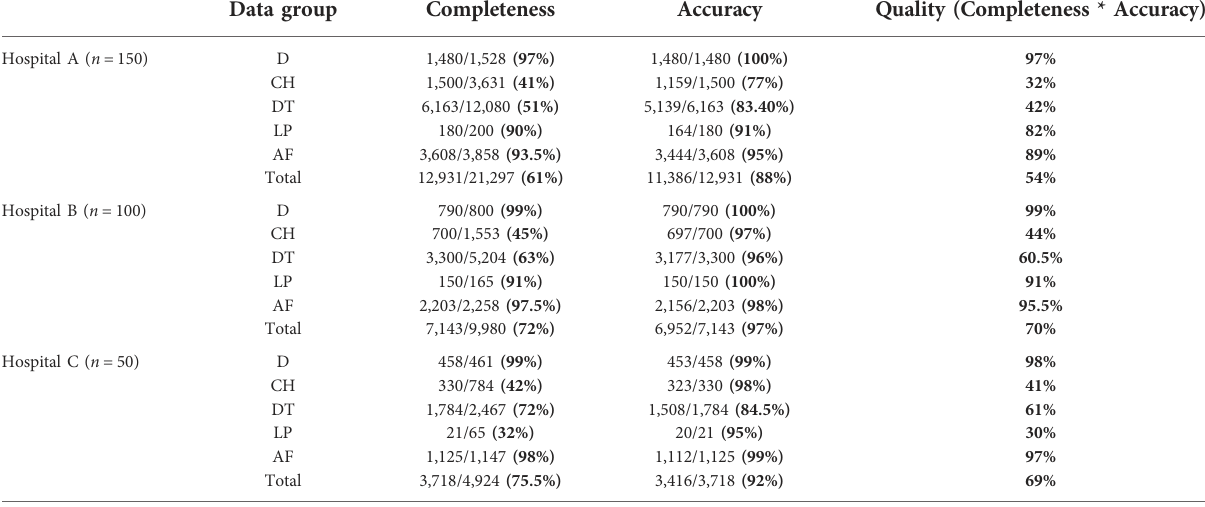
TABLE 4 Completeness, accuracy and quality of data groups concerning entire data